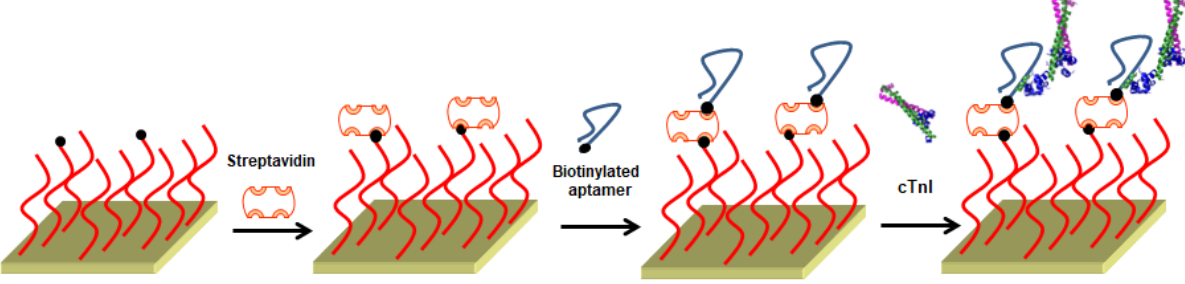
Figure 5. A pictorial illustration of the multistep process used for the cTnI biomarker detection. The peptide-modified gold layer was used for the SPR experiments by first attaching Streptavidin, then immobilizing biotinylated aptamers on the SPR surface. Adapted from Ref. [112].